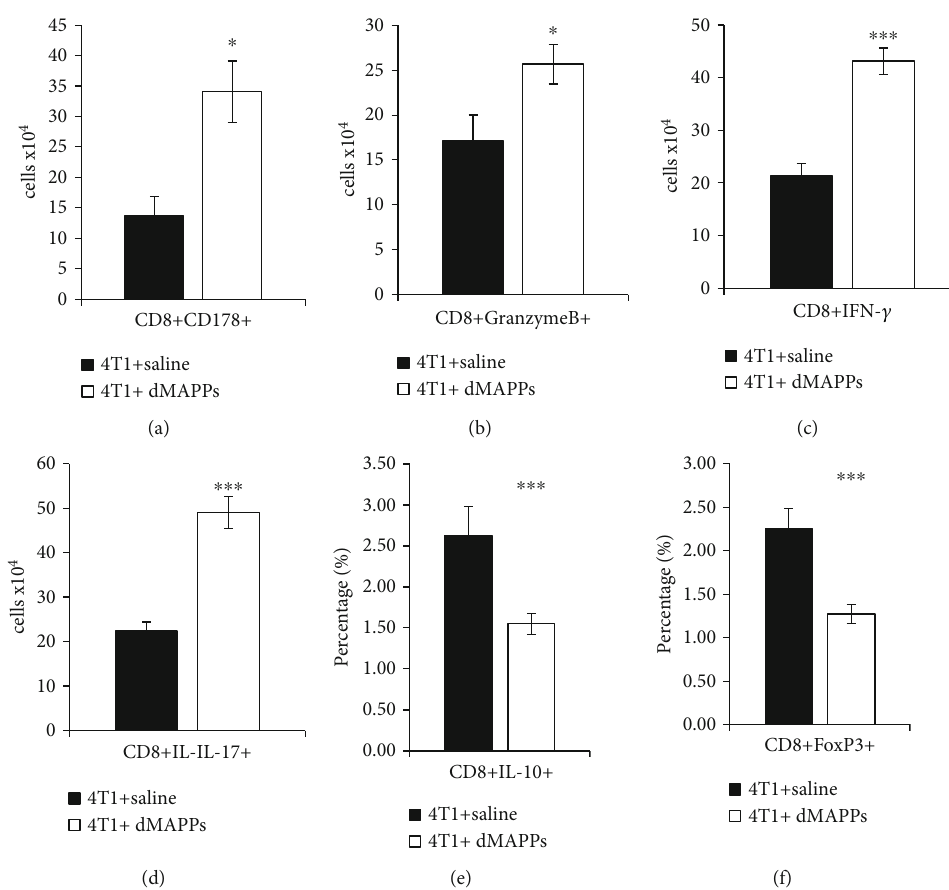
Figure 6: d-MAPPS increased number of tumoricidal CD8+ CTLs and decreased presence of immunosuppressive CD8+ T cells in the tumors of 4T1-treated mice. Total number of (a) tumorotoxic CD178+CD8+ CTLs, (b) granzyme B-expressing CD8+ CTLs, (c) IFN- γ - producing CD8+ Th1, and (d) IL-17-producing CD8+ Th17 cells and percentage of (e) immunosuppressive IL-10-producing CD8+ and (f) FoxP3-expressing CD8+ T regulatory cells in the tumors of 4T1+saline-treated (black bars) and 4T1+d-MAPPS-treated mice (white bars), as determined by the fl ow cytometry analysis and intracellular staining of tumor-in fi ltrated mononuclear cells. Data are presented as mean + / − SEM ( n = 16 mice/group; ∗ p < 0 : 05 ; ∗∗∗ p < 0 : 001